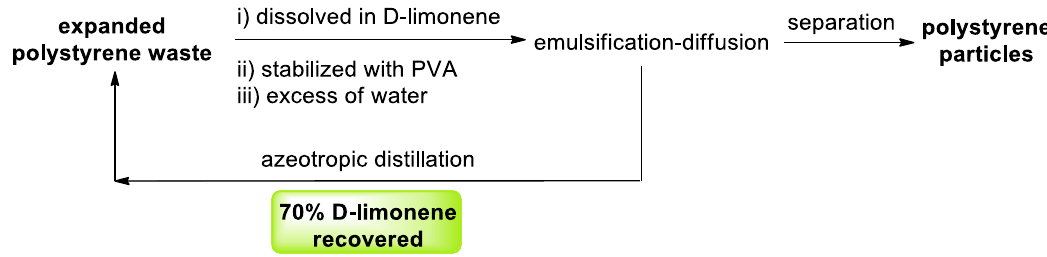
Scheme 13. Synthesis of value-added polystyrene particles from expanded polystyrene waste